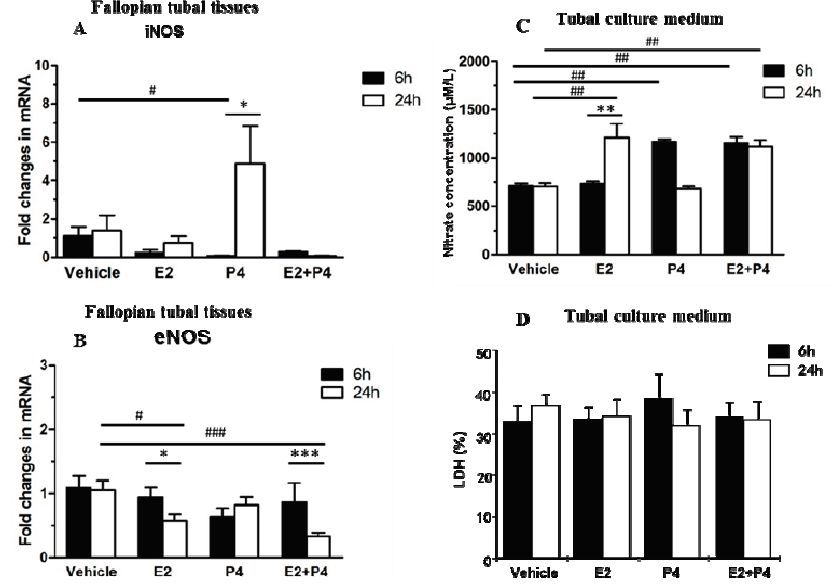
Figure 5. Time-dependent regulation of iNOS and eNOS expression in mouse Fallopian tubes following steroid hormone treatment. ( A ) The iNOS mRNA level in mouse Fallopian tubes in vitro . The expression of iNOS mRNA was significantly up-regulated from 6 to 24 h following P4 treatment but not following E2 or E2 plus P4 together ( p < 0.05); ( B ) The eNOS mRNA level in mouse Fallopian tubes in vitro . The expression of eNOS mRNA was down-regulated from 6 to 24 h following E2 and E2 plus P4 treatment together but not after P4 treatment; ( C ) The nitric oxide concentration in tubal culture medium in vitro . The nitric oxide concentration was significantly lower after 6 h in tissue cultured with P4 or E2 plus P4. The nitrate concentration was lower after 24 h in culture medium containing E2 and E2 plus P4; and ( D ) The LDH level in the tubal culture medium as measured by the optical density on a microplate fluorometer at a wavelength of 490